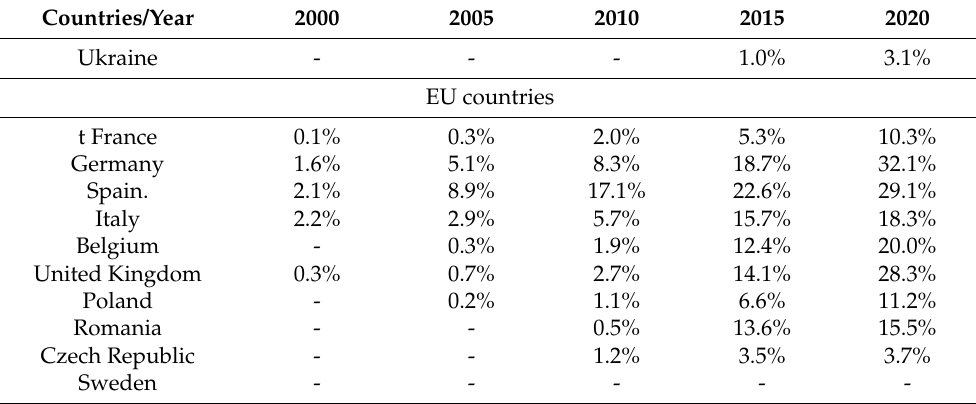
Table 2. The share of wind and solar energy sources in electricity production in the EU countries and in the Ukraine 2000–2020